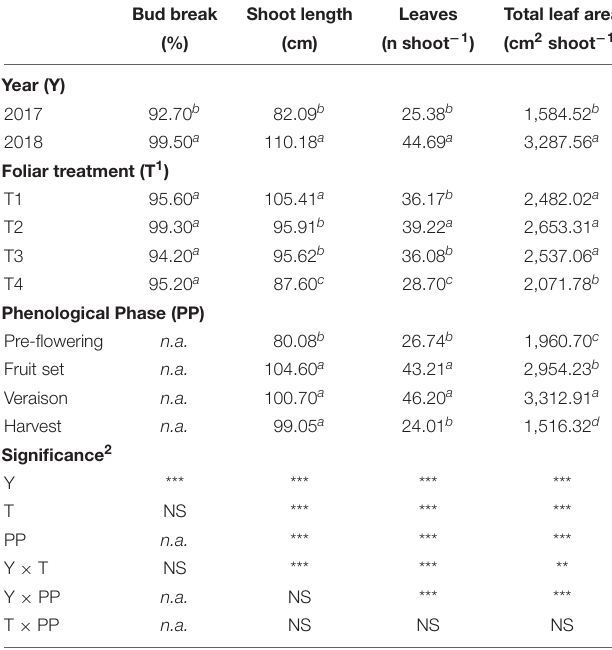
TABLE 1 | Main effects of year, foliar treatment and phenological phase on vine bud break, shoot length, number of leaves per shoot, total leaf area per shoot of V. vinifera “Aglianico” vines. Mean values and significance of main factors’ interactions are shown. Different letters within column indicate significant differences according to Duncan’s multiple-range test ( P ≤